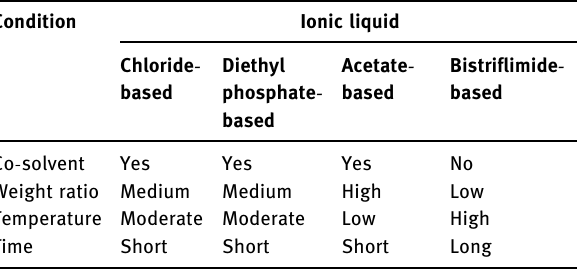
Table 8: Pretreatment conditions for four types of ionic